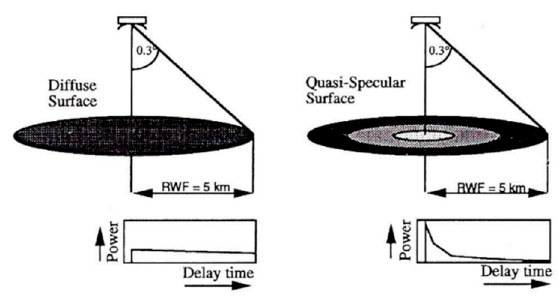
Figure 1. Di ff erences in the radar altimeter returns over the di ff use and quasi-specular surfaces Figure 1. Differences in the radar altimeter returns over the diffuse and quasi-specular surfaces [6,7] .